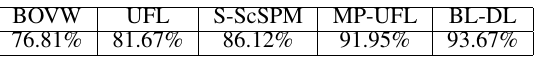
Table 3. Performance of different DL methods on UC Merced data